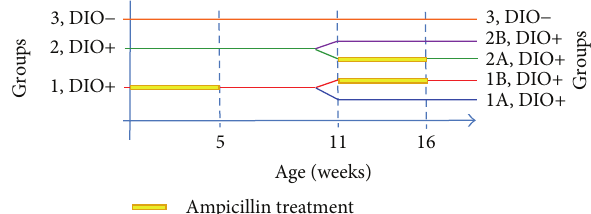
Figure 1: Experimental design for diet-induced obesity (DIO) and Ampicillin treatment in